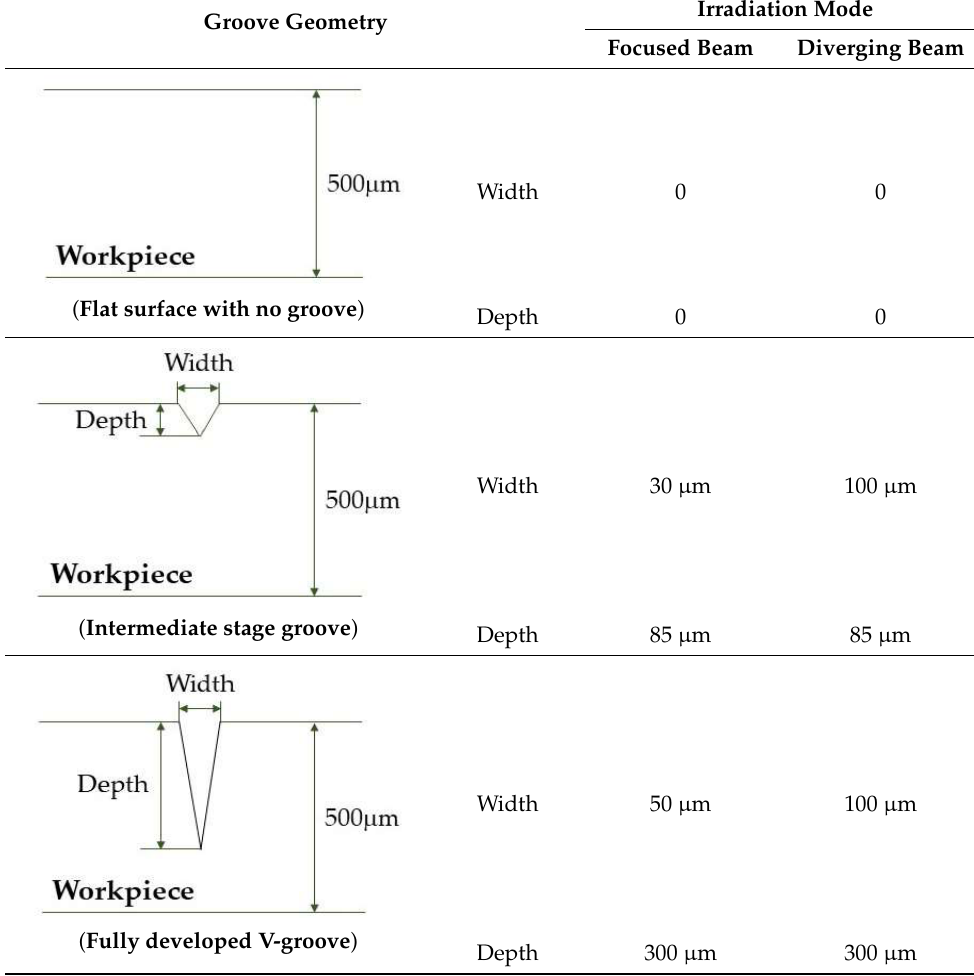
Table 1. Three types of groove geometry for ray tracing calculation.